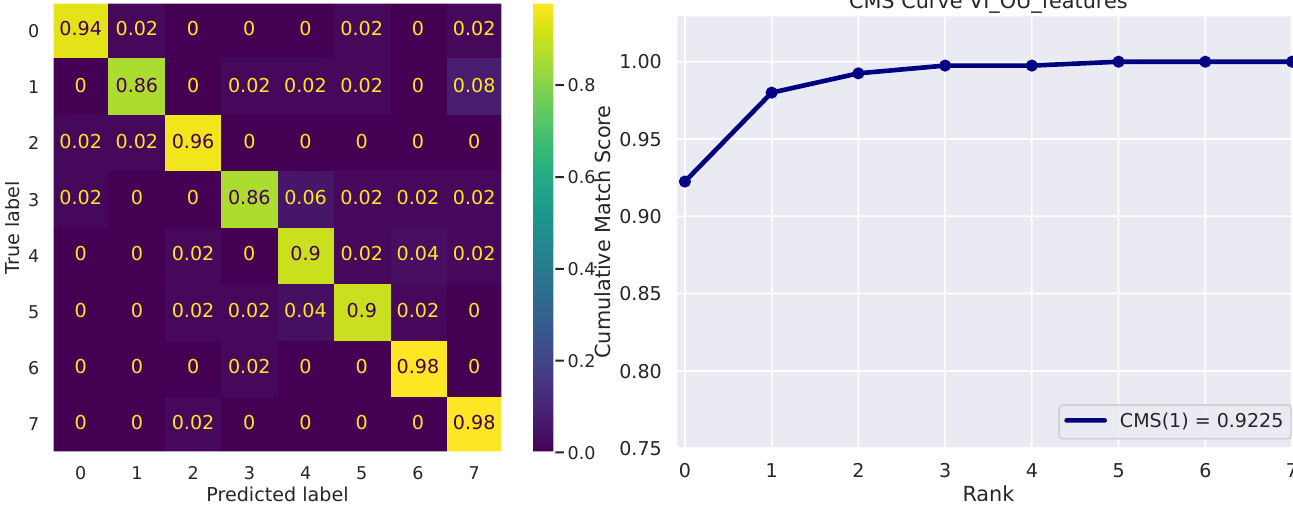
Figure 6. Confusion matrix ( left ) and Cumulative Match Score (CMS) curve ( right